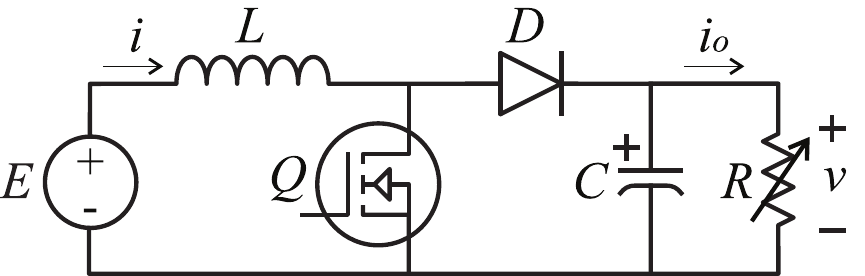
Figure 1. Basic Boost converter schematic with a variable resistive load whose value is modified to achieve a constant output power (CPL).